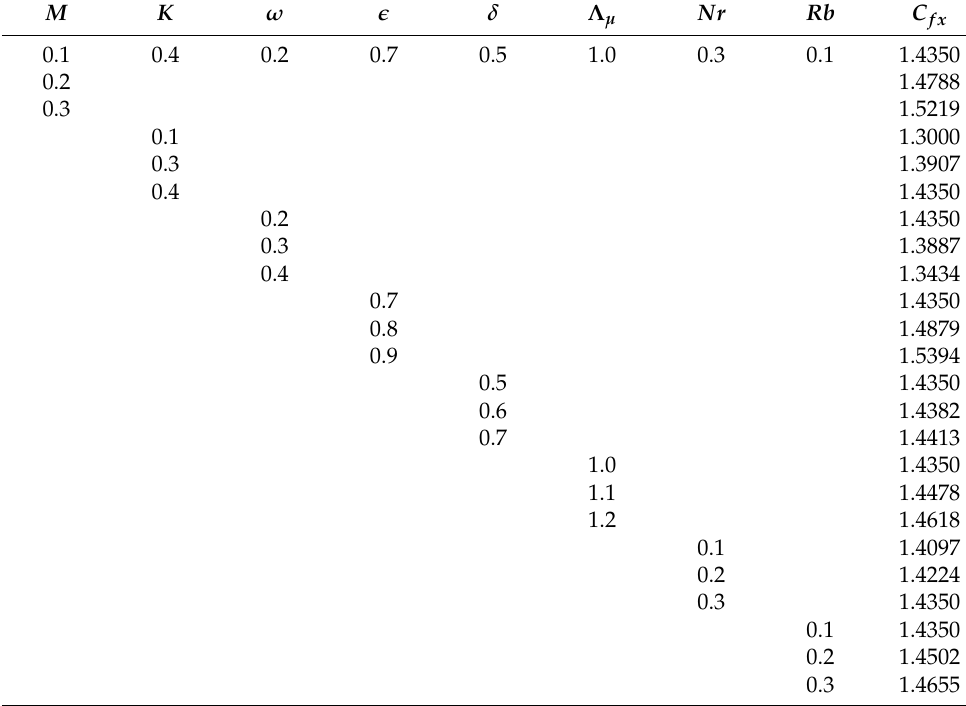
1 ) 1 2 (( 1 + (cid:101) ) f (cid:48)(cid:48) ( 0 ) − δ(cid:101) 2 x C fx = ( m + 1 2